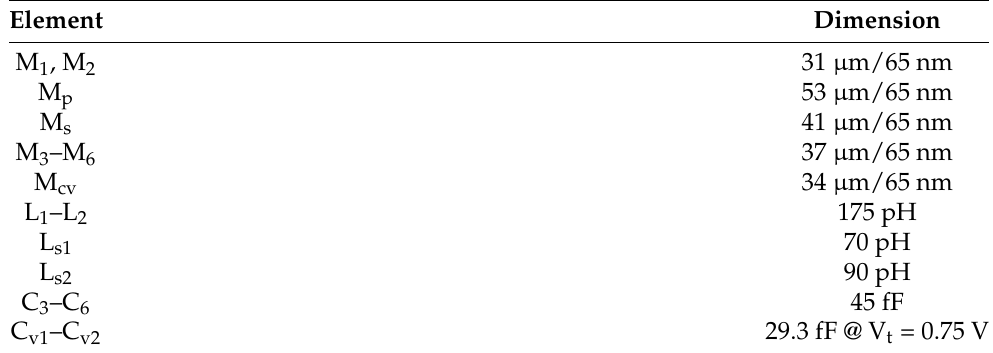
Table 1. Designed mixer circuit component